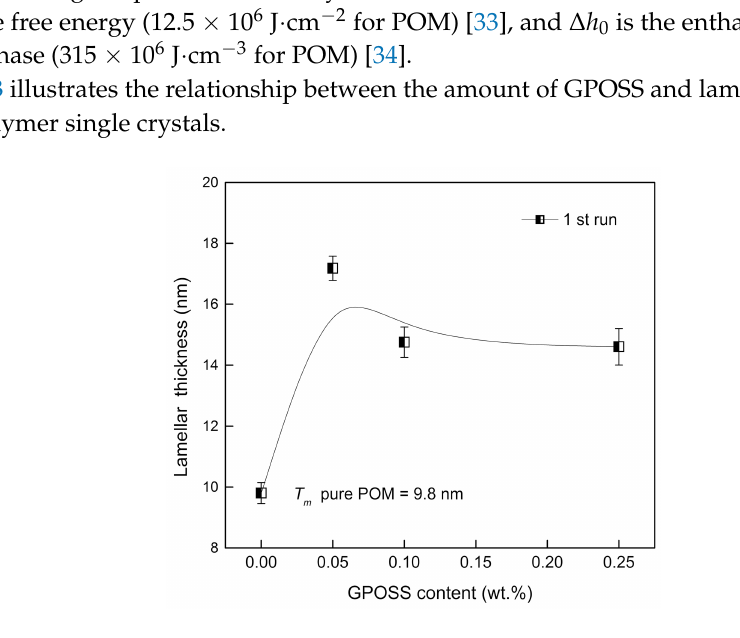
Figure 3. The variation in the lamellar thickness of pure POM and its composites, calculated from DSC (first run) experiments as a function of GPOSS content.